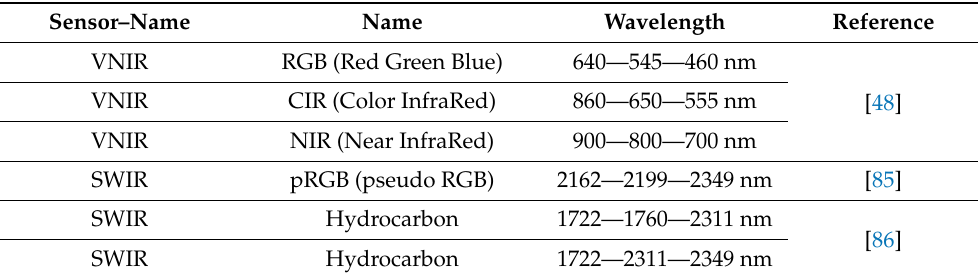
Table 2. Example of composite image estimated from